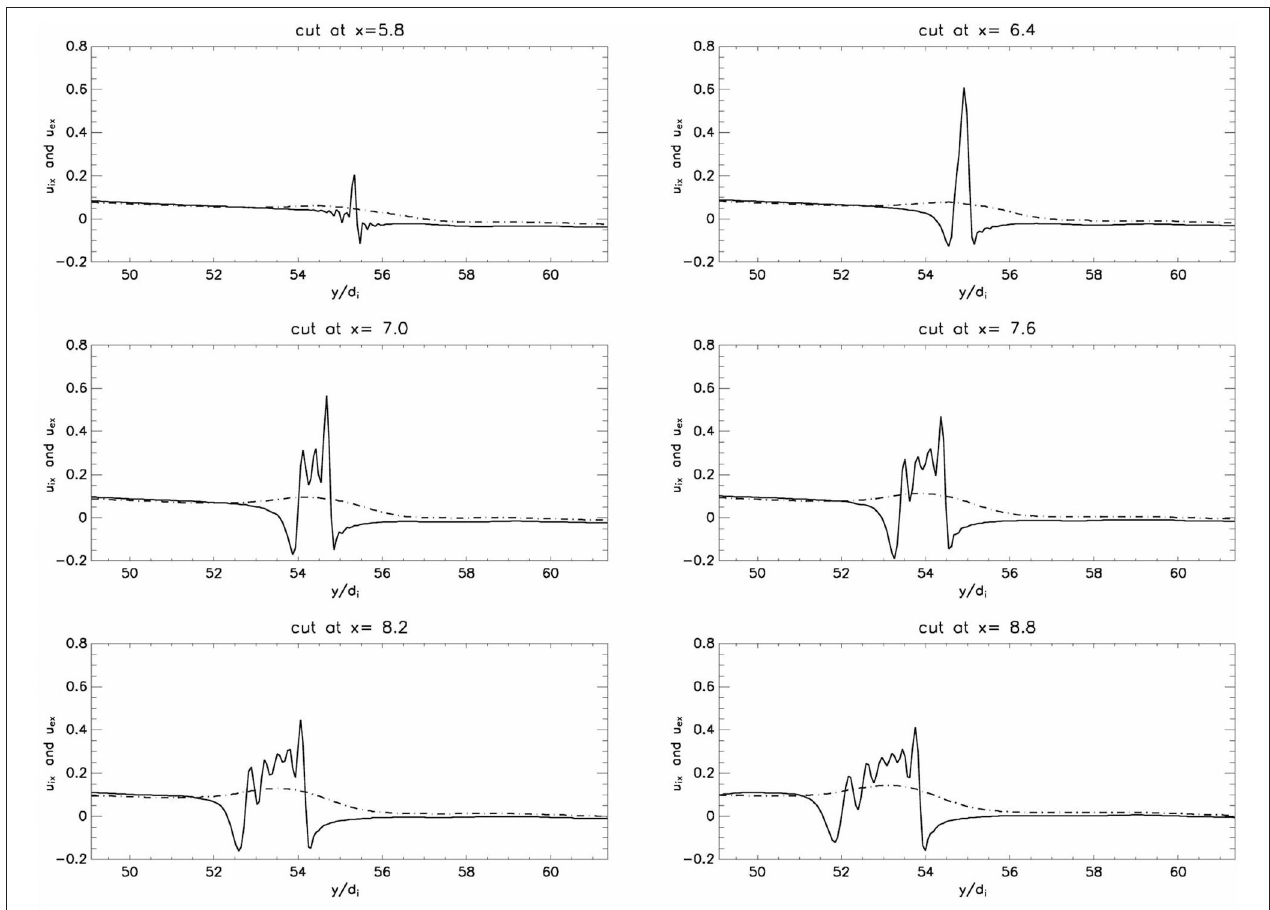
FIGURE 7 | From sim.B. Cuts vs. y of the rightward outflow from the X-point shown in Figure 6 , at t (dash-dotted) velocities are plotted vs. y at different values of x starting close to the X-point and going as far away as 3 d i